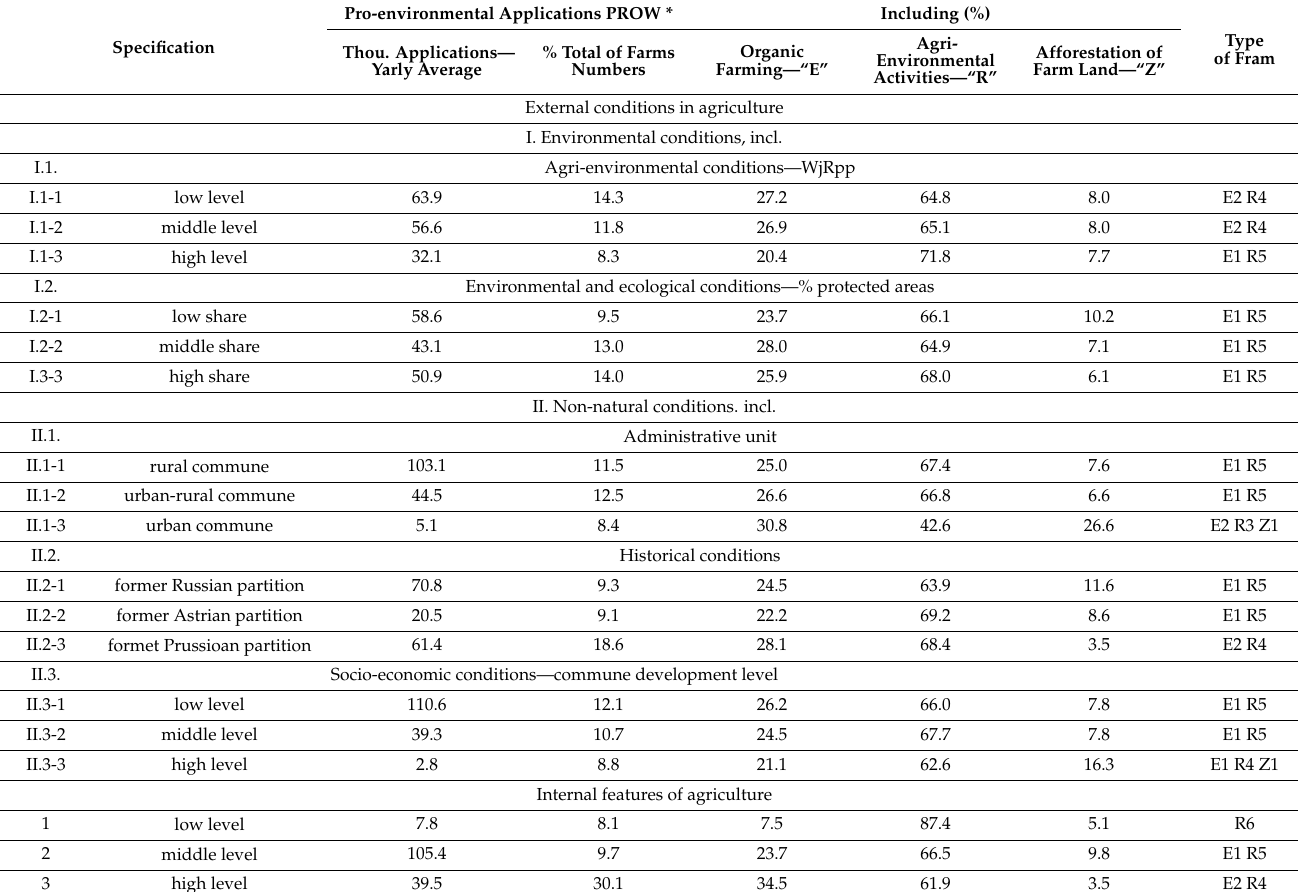
Table 6. Pro-environment RDP applications—conditions of spatial